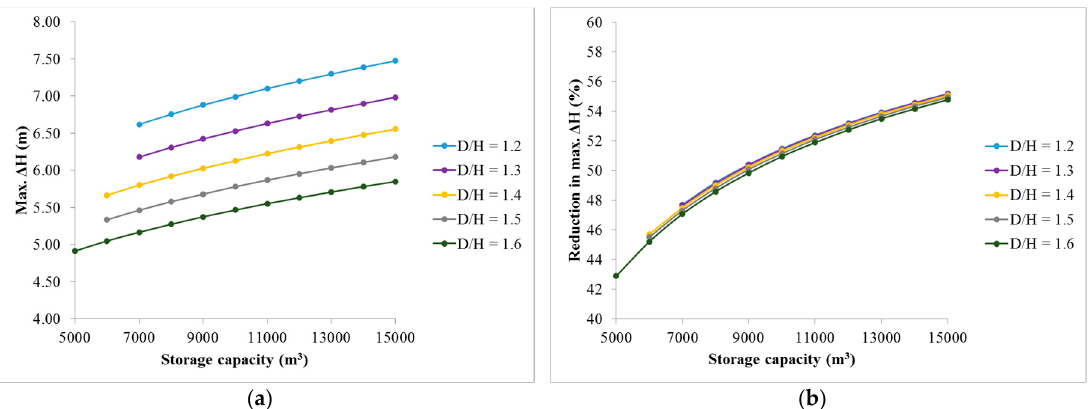
Figure 32. Hydrostatic pressure on tank inner wall: ( a ) maximum pressure head and ( b ) reduction in maximum pressure head.